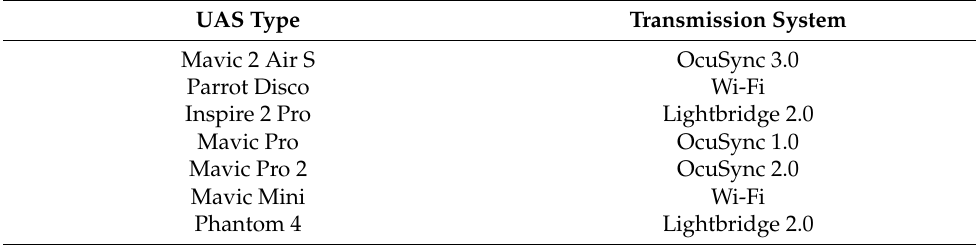
Table 3. UAS Transmission